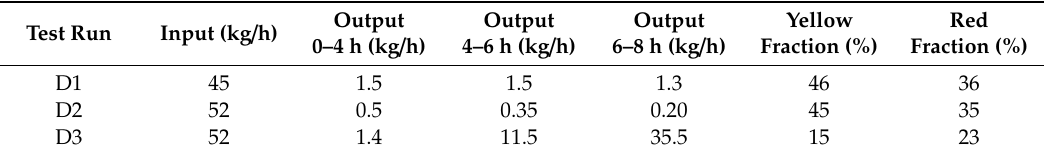
Table 5. Delta formation test runs D1–D3: transport rates, ratio of fed sediment (input) vs. transported sediment (output), transported fractions of the yellow (0.7–1.2 mm) and red (1.2–2 mm) grain size class after 8 h.